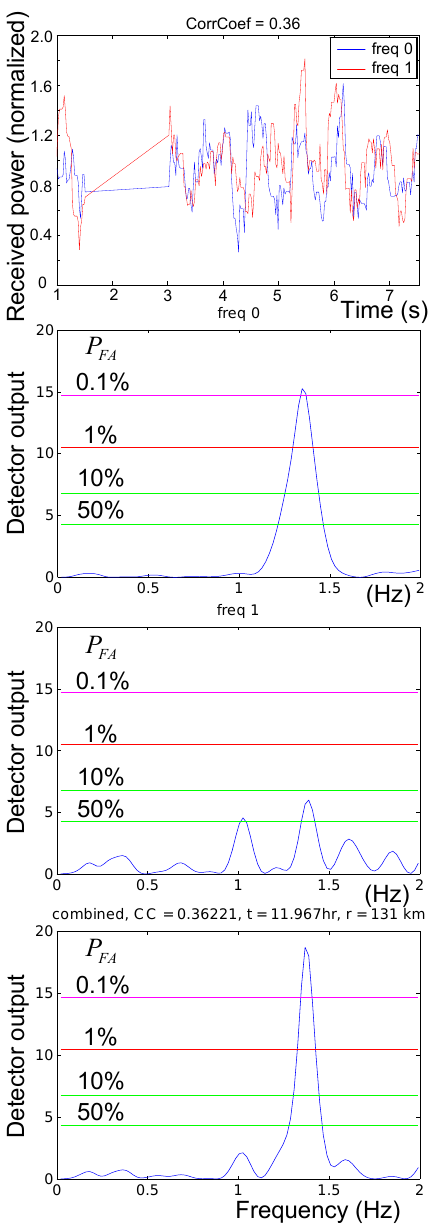
Fig. 3. Beam 3 weighted time series and detector output for the two radar frequencies, and for the combined time